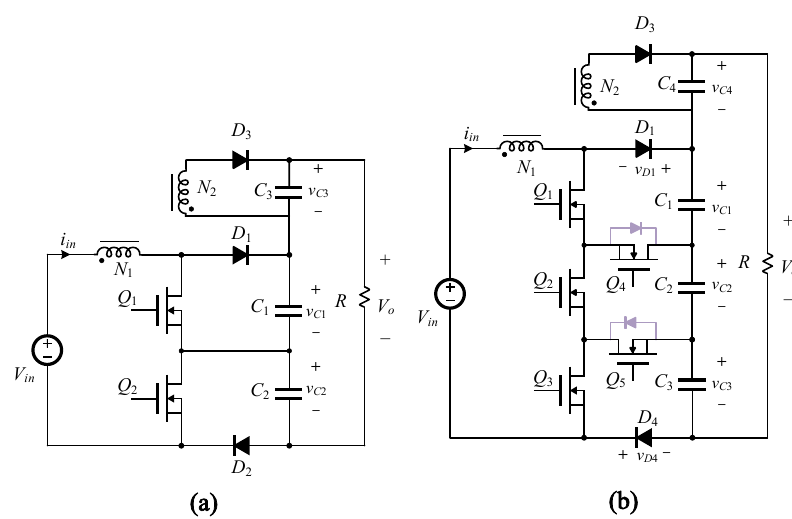
Figure 4. Illustration of using the flyback transformer with the multilevel converter: ( a ) the three-level boost converter with the flyback transformer; ( b ) the four-level boost converter with the flyback transformer. Table 1. Summary of the high voltage gain converters shown in Figures 3a–c and 4. Figure 3b Figure 3c The Proposed Converter, Figure